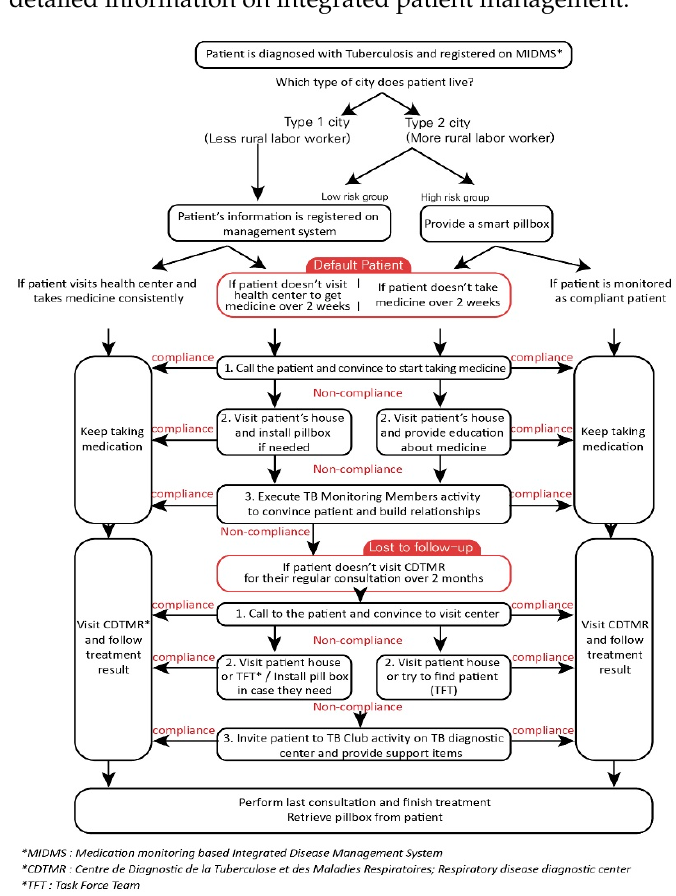
Figure 1. Protocol of the integrated patient management program.